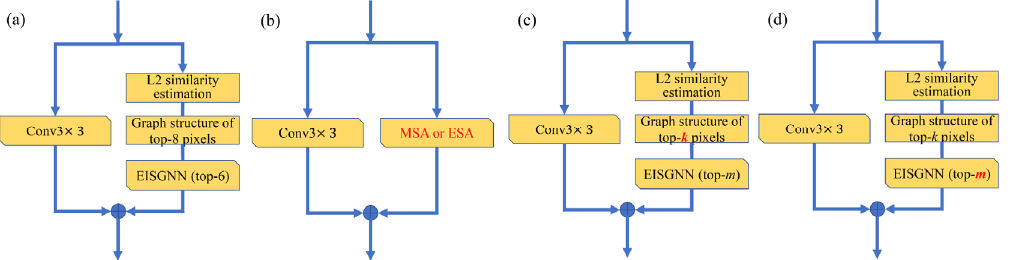
Figure 12. Ablation experiment settings of network hyperparameters. The red parameters indicate the parts that changed in ablation experiments. ( a ) Original structure of CGBlock, with a CNN branch on the left and a GNN branch on the right. ( b ) CGBlock after the GNN branch is replaced by an attention module. ( c ) Different numbers of pixels selected to construct a graph. k indicates the pixel number in the selective aggregation. ( d ) Different numbers of neighbor nodes in feature aggregation. m indicates the number of selected neighbor nodes.